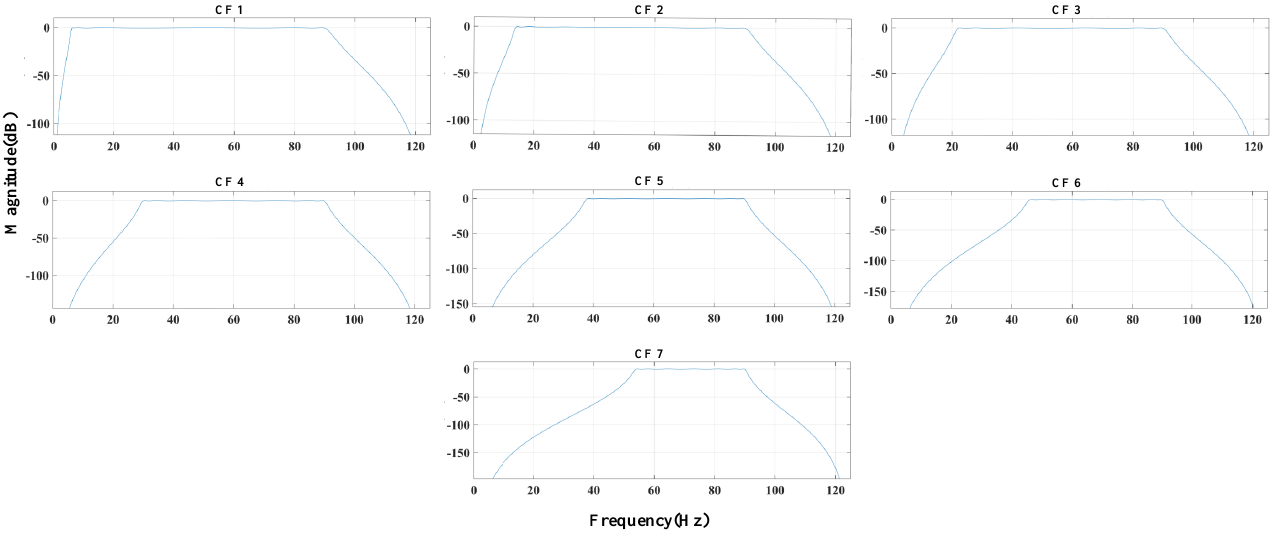
Figure 2. Bode diagram of the filter